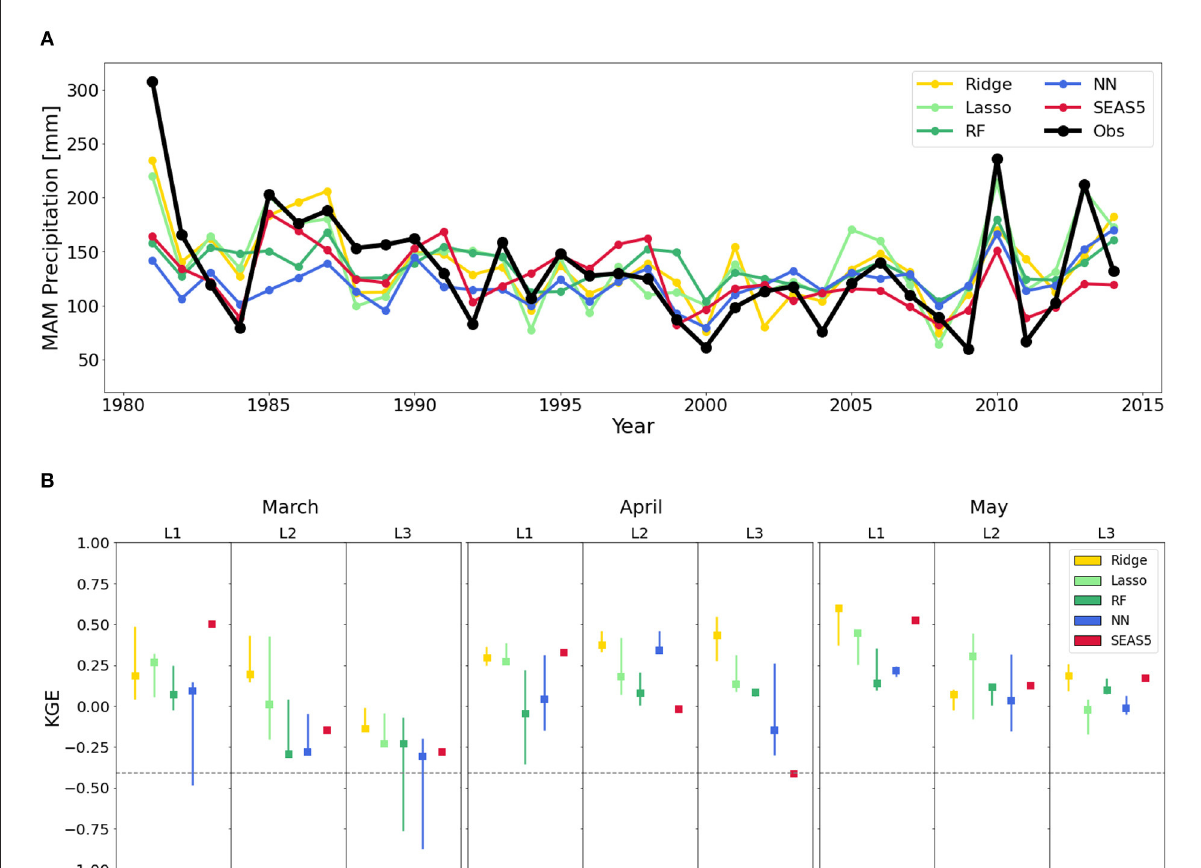
FIGURE3 Performance of the conventional A1 approach for predictor selection. (A) Time series of observations and hindcasts of the nested cross-validation procedure of all modeling methods for MAM at a 1-month lead-time representing the first approach where correlation-based predictors were done on the whole dataset (A1). (B) Median and interquartile ranges illustrating the Kling–Gupta Efficiency (KGE) performances of the cross-validation procedure for the four data-driven models and the dynamical hindcast at all lead-times (L1–L3). RF and NN refer to the random forest and the single-layer neural network, respectively. KGE-values > − 0.41 (see discontinuous line) indicate some skill compared to using the climatological mean as